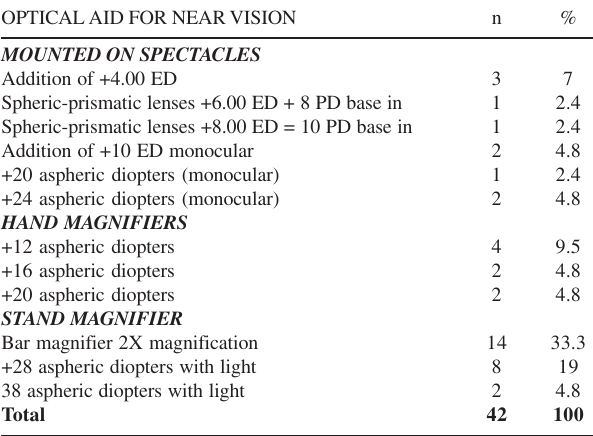
Table 5 - Distribution of frequency of prescribed optical aids for near distance in the pediatric population with low vision